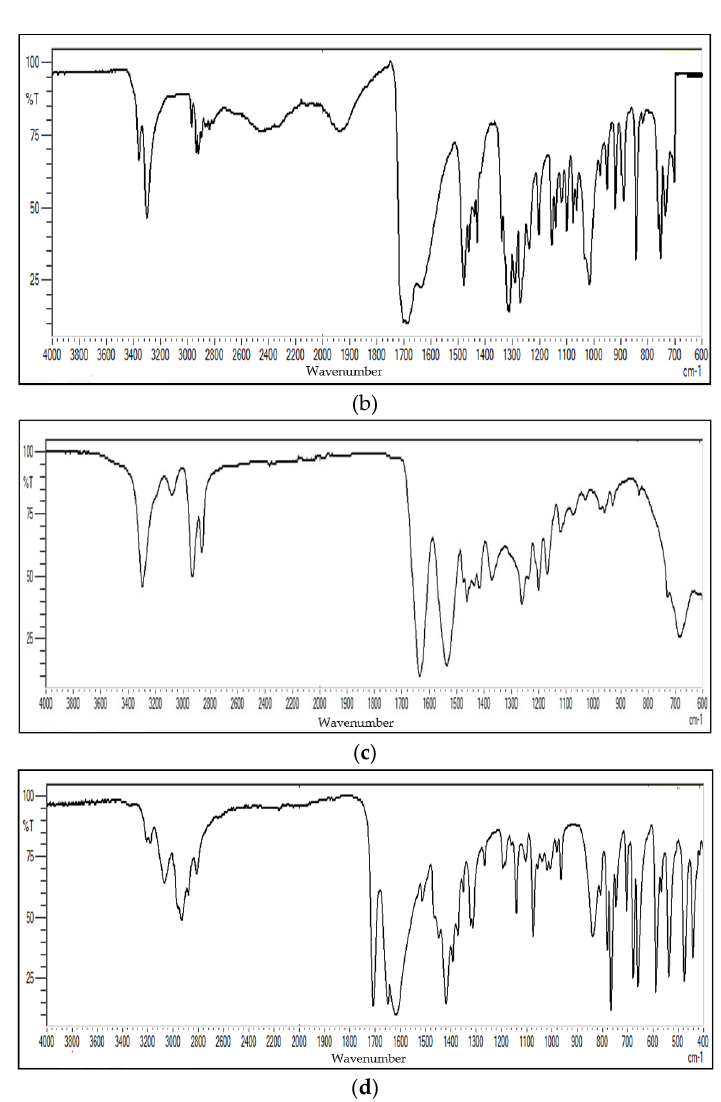
Figure 7. Fourier-transform-infrared (FT-IR) spectrometric analysis of the four samples. From up to down: ( a ) TCA-AgNP; ( b ) TCA-AgNP-PI; ( c ) Cinn-AgNP; ( d ) Cinn-AgNP-PI.